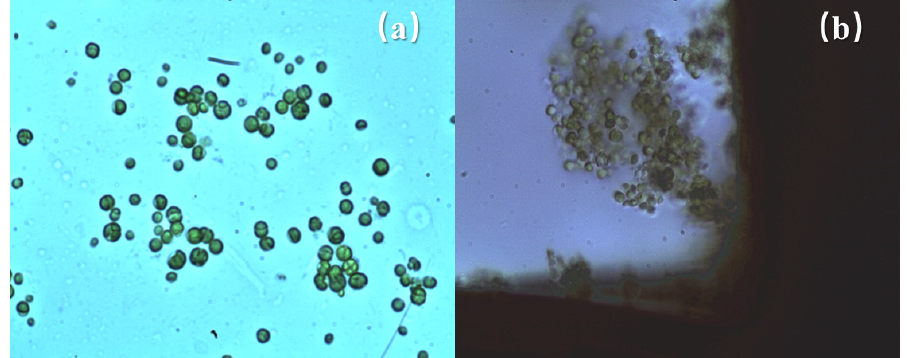
Figure 3. ( a ) Microscopic image of Anabaena cells without DEP treatment; ( b ) microscopic image of DEP-treated Anabaena cells. (400 times).